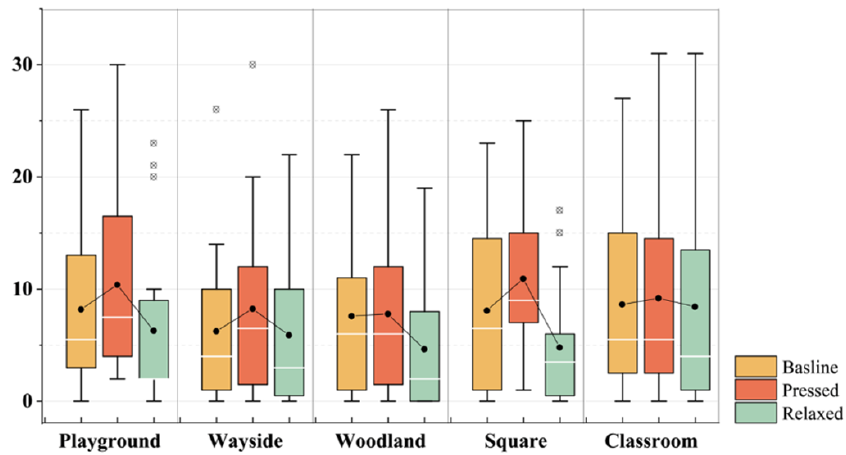
Figure 3. Eye strain level of baseline, post-stress, and post-relaxation in different settings. Table 3. T-test results between post-stimulus and post-relaxation. Plot Baseline Post-Stimulus Post-Relax Wayside greenspace